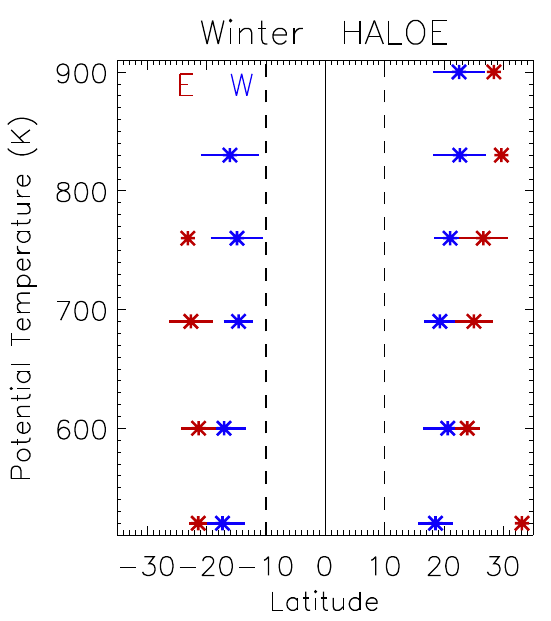
Fig. 10. Wintertime (DJF NH, JJA SH) vertical evolution of the subtropical barrier position during the Westerly (blue) and Easterly (red) QBO phase, based on the QBO composite of the HALOE data set.